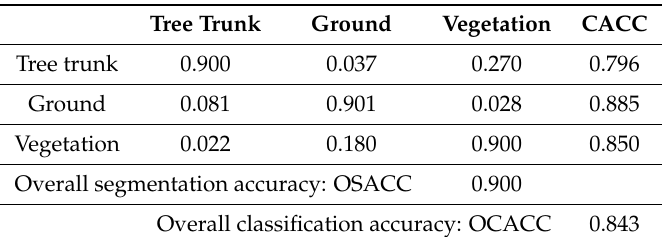
Table 3. Segmentation and classification results for the Forêt de Tronçais data set (Data_set-2), sessile oak trees ( Quercus petraea (Matt.)